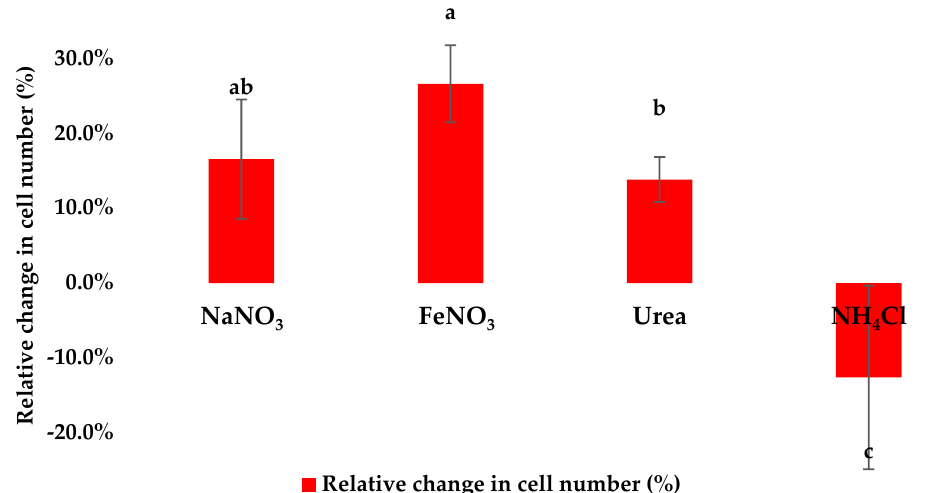
Figure 2 . The relative change of H. pluvialis CCAP 34/1D cell number is based on the number of cells/mL at the beginning and end of the 7-day induction process, and thereby representative of the cell number change during the red phase alone. Error bars are standard deviations of the means, n = 3. Different letters indicate significant differences among the different nitrogen source treatments ( p < 0.05).